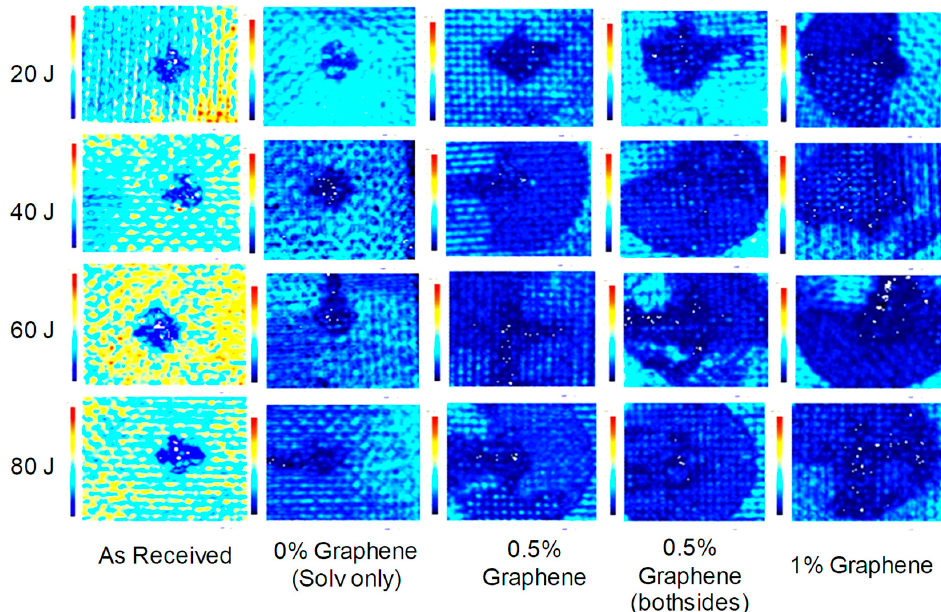
Figure 15. Ultrasonic images of impacted graphene coated glass fiber composites at different energy levels.